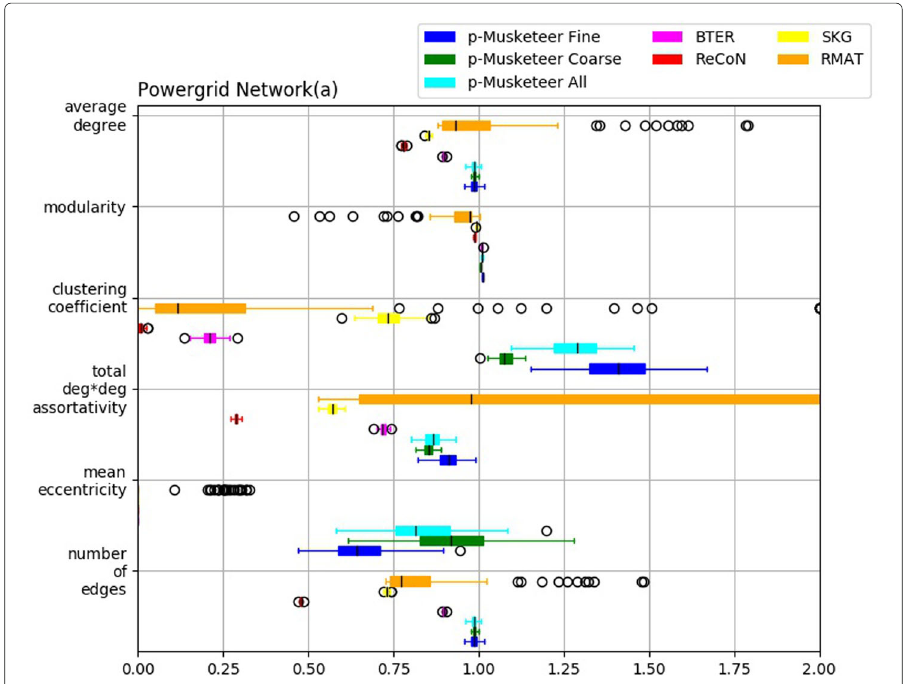
Fig. 2 Computational results on performance of planar Musketeer on power grid graph opsahl-powergrid with 4941 nodes and 6211 edges for clustering coefficient, number of edges, mean eccentricity, total degree *degree assortativity, modularity and average degree